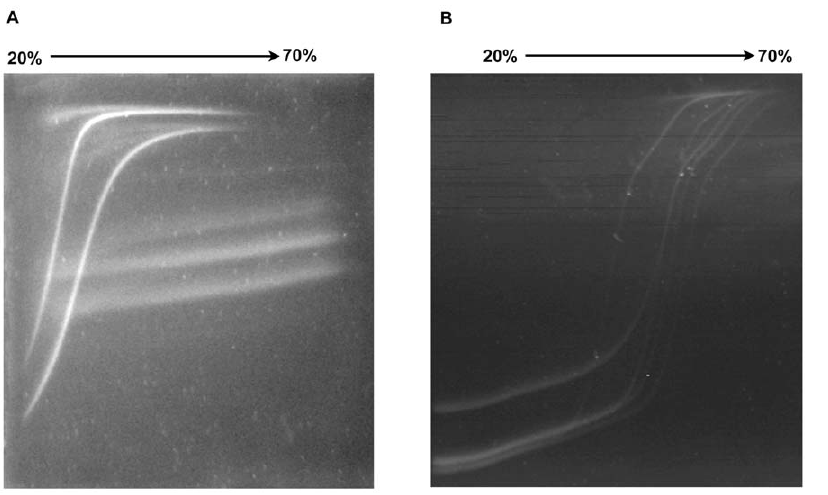
Figure 5. Perpendicular DGGE analyses of all selected variants for both segments. Panel A: resolution of variants in segment 5 with and without insert. Panel B: Resolution of all five HPR variants (HPR0, HPR2, HPR5, HPR7b and HPR8, correspondingly).